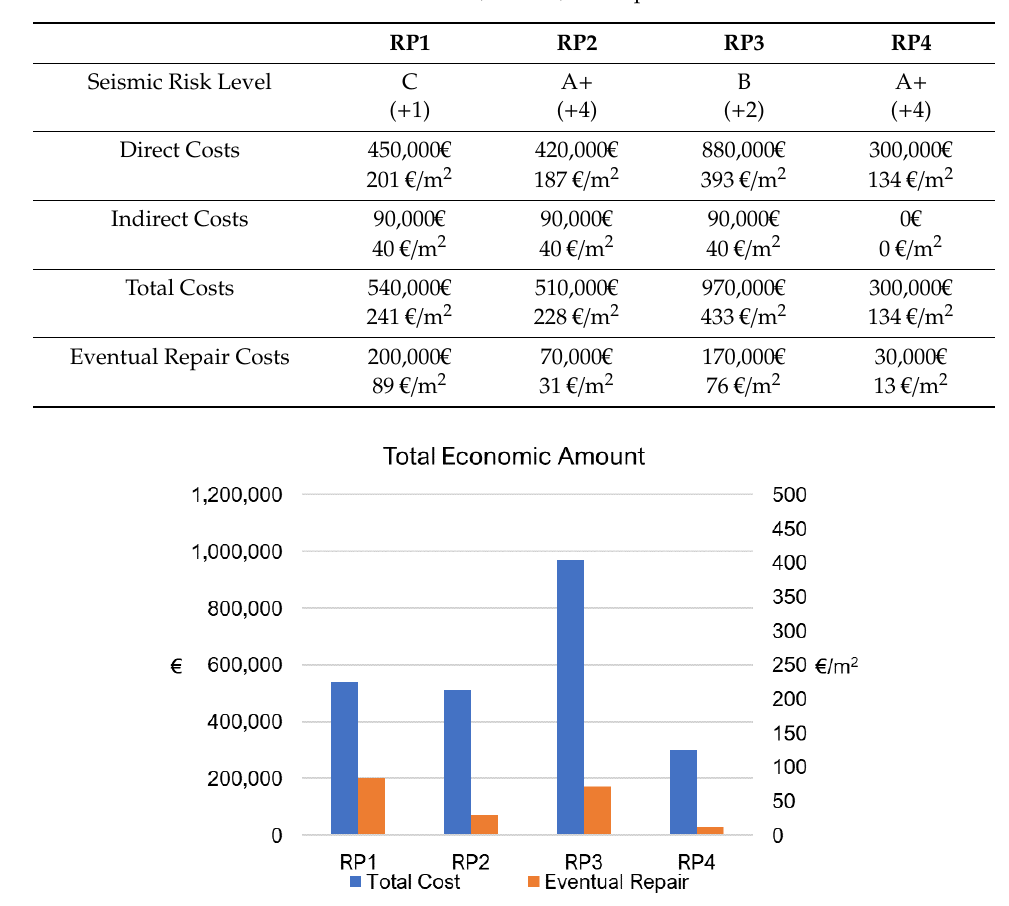
Table 8. Achieved seismic risk level, retrofit, and repair costs for di ff erent RPs.